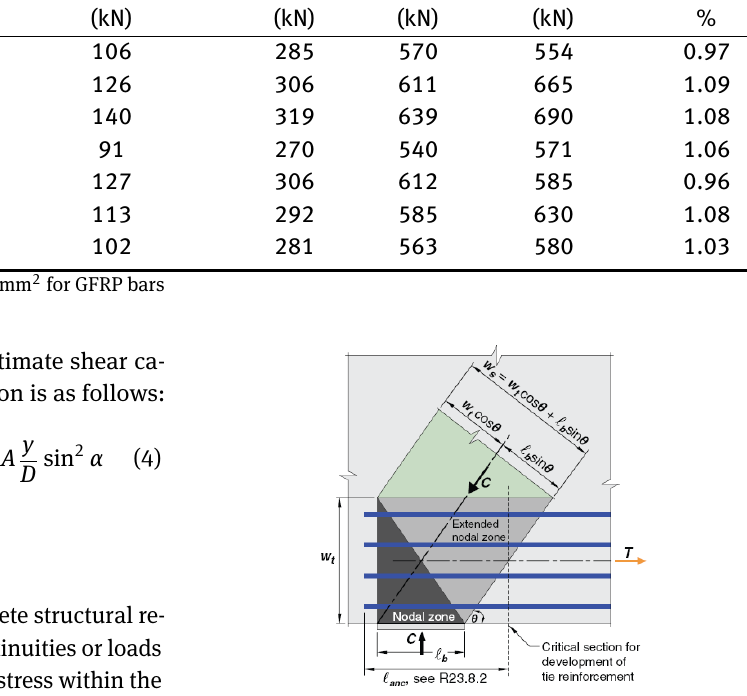
Table 8: Measured and computed ultimate load deep beams by using modified equation by authors Specimens ID